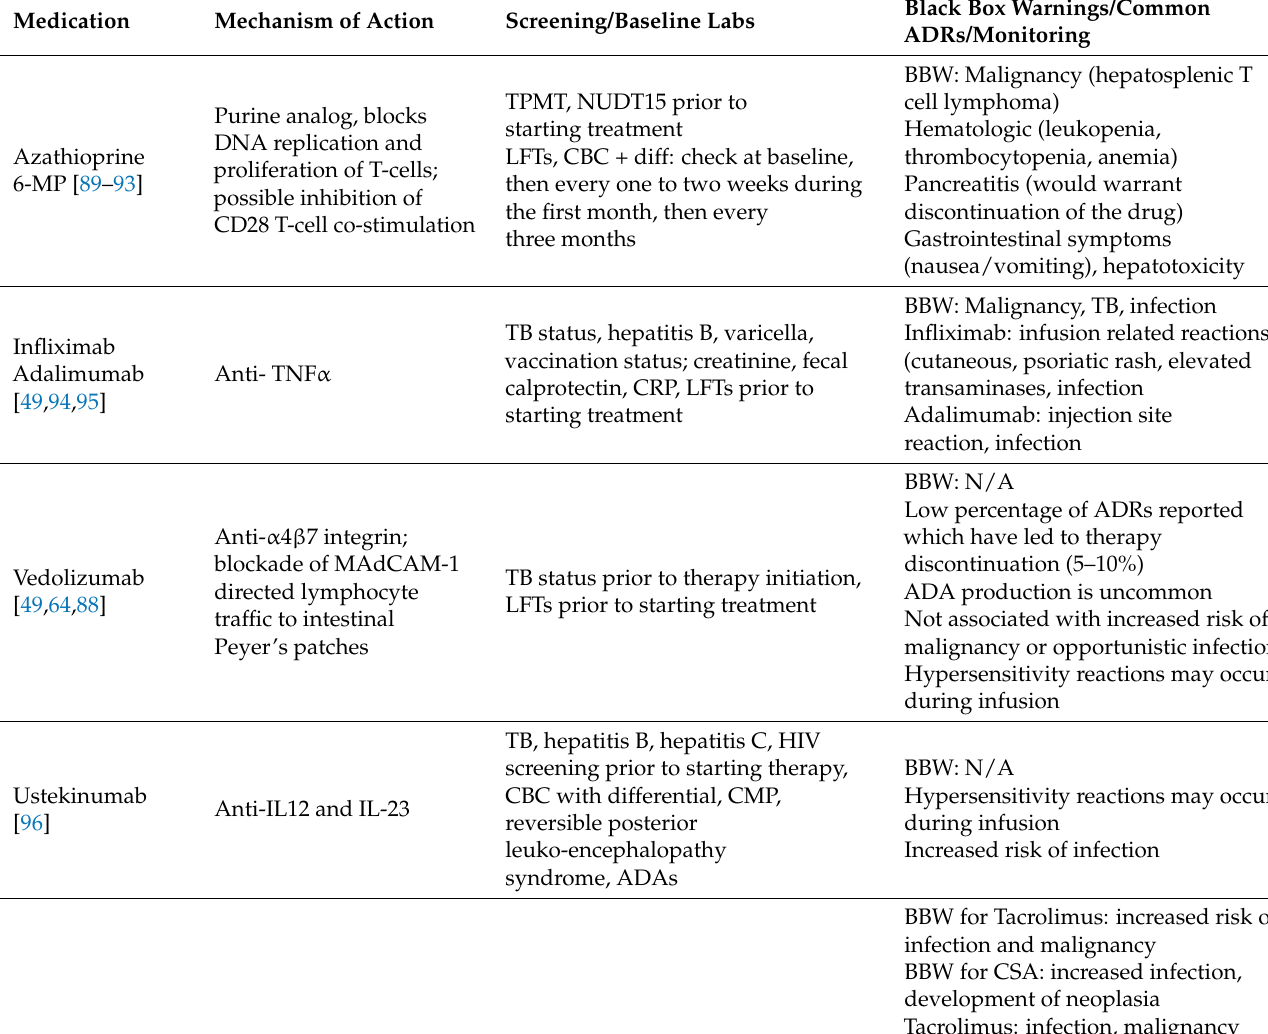
Table 3. Baseline Screening and Monitoring for Immune-Targeted